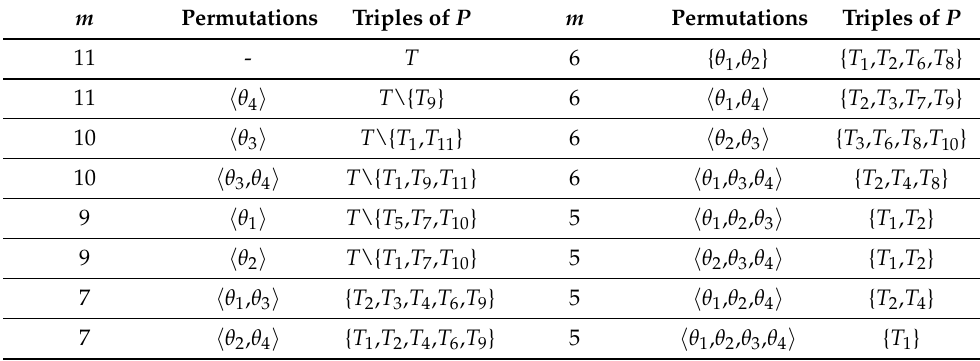
Table 1. Access level definitions in